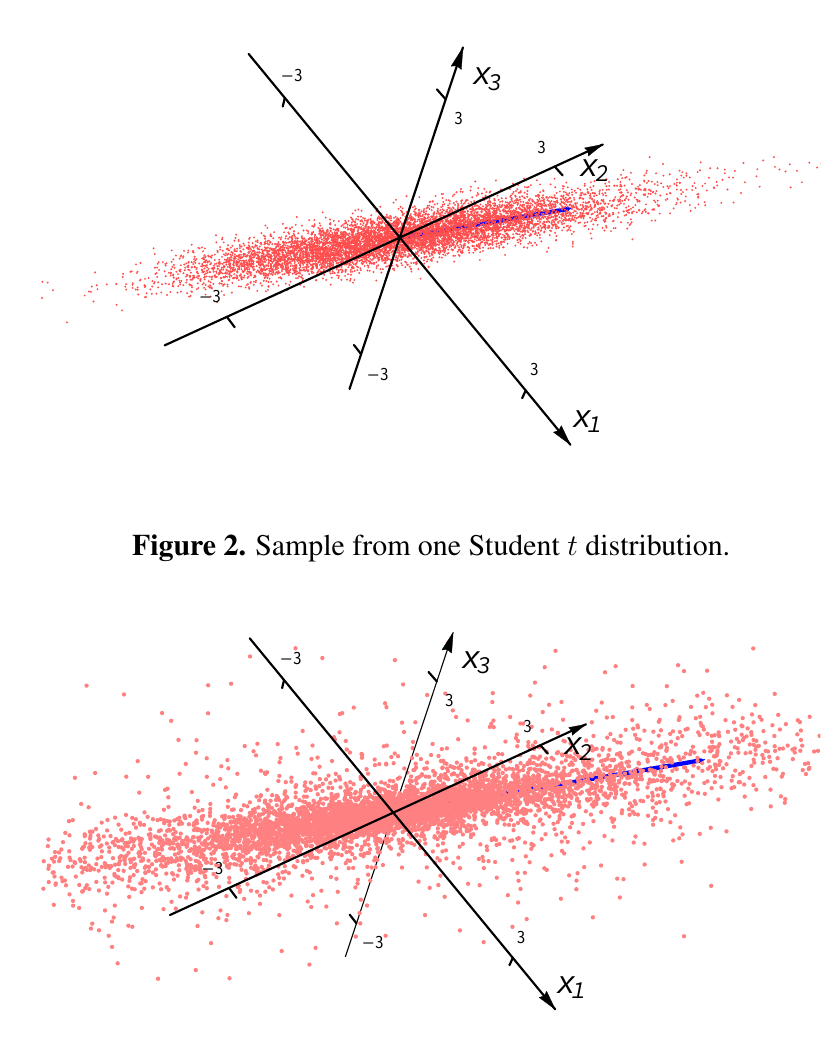
Figure 1. Sample from one Gaussian distribution.